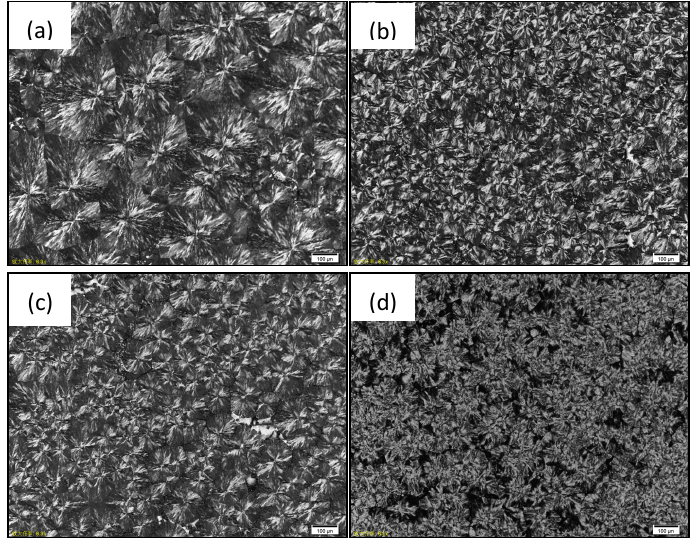
Figure 4. Polarized light microscopy (PLM) images of ( a ) neat POM; ( b ) POM/TBOP-TFSI (100-0.5); ( c ) POM/TBOP-TFSI (100-1); ( d ) POM/TBOP-TFSI (100-3) isothermally crystallized at 152 ◦ C.